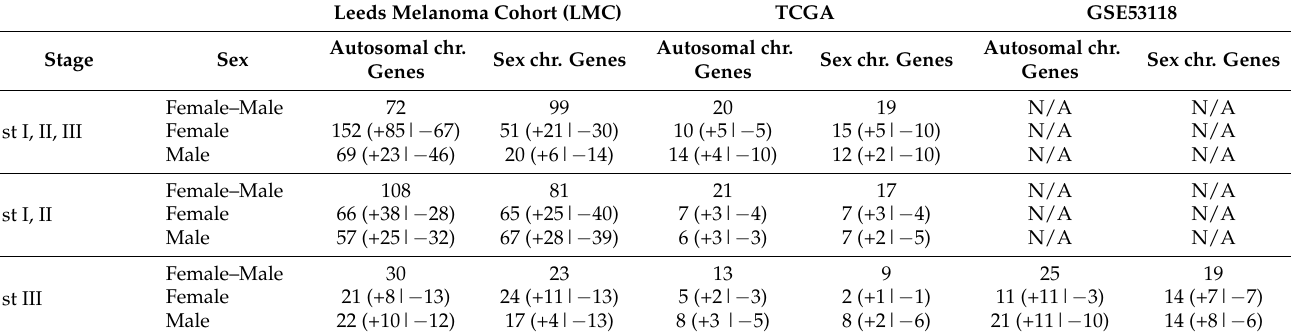
Table 3. Multivariate Cox regression analysis on the LMC, TCGA, and GSE53118 melanoma dataset. Analysis was performed on autosomal and sex chromosome genes on females and males together for stages I, II, and III combined, stage I, II, and stage III. The same analyses were performed for the stage categories by separating the sexes. The significant genes obtained within each sex and stage subcategory are assigned with a “+” if associated with better overall survival and with a “ − ” if associated with worse overall survival. TCGA